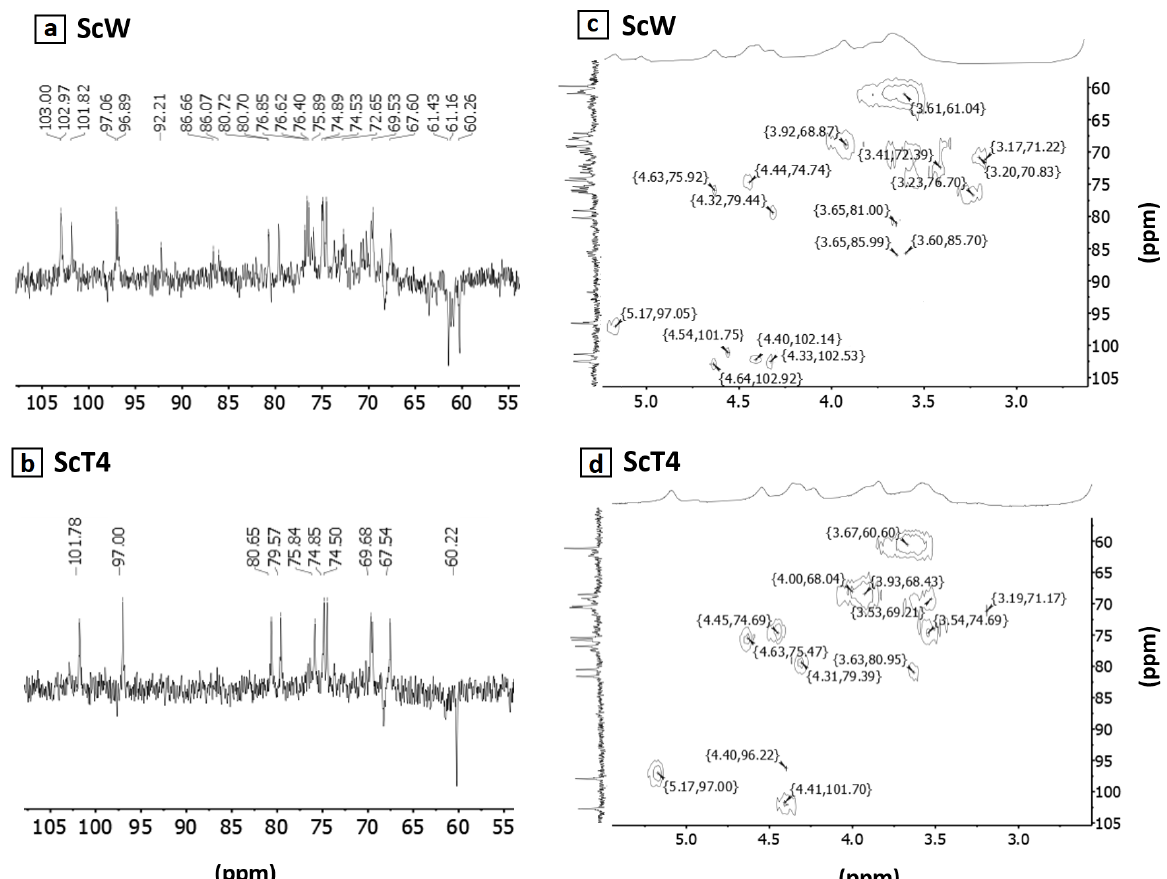
Figure 2. a - 13 C-DEPT NMR spectra for wild (ScW). b - 13 C-DEPT NMR spectra for T4 mutant S. commune (ScT4) polysaccharides. c - HSQC spectrum of the ScW fraction in deuterated dimethyl sulfoxide. d - HSQC spectrum of the ScT4 fraction in deuterated dimethyl sulfoxide. Chemical shifts relative to the 13 C NMR-DEPT signals were expressed as δ